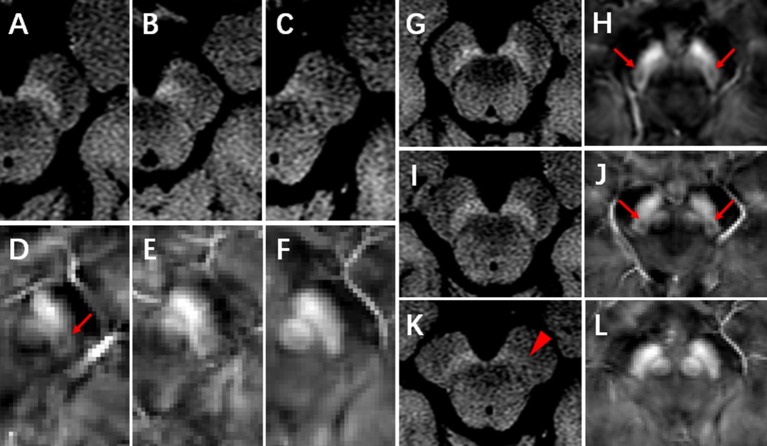
NM-MRI and QSM images. (A–C) represent the normal, possibly abnormal, and definitely abnormal SN on NM-MRI, respectively. Nigrosome-1 (N1) could be visualized in the dorsal part of the healthy SN on QSM images (D, arrow). (D–F) represent that N1 was present, indecisively present and absent, respectively. (G,H), a control subject, female, 65 years, neuromelanin was normal (G) and N1 was present (H, arrow) in bilateral SN. (I,J), an ET patient, 59 years, female, neuromelanin was normal (I) and N1 was present (J, arrow) in bilateral SN. (K,L), a de novo PD patient, 75 years, female, neuromelanin was definitely abnormal in unilateral SN (K, arrowhead) and N1 was absent in bilateral SN (L).